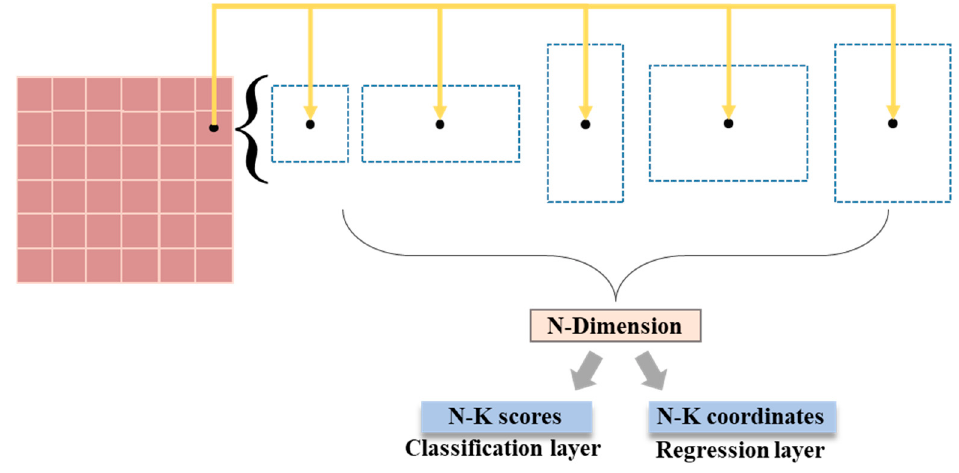
Figure 6. Anchor Box Shapes in the RPN.